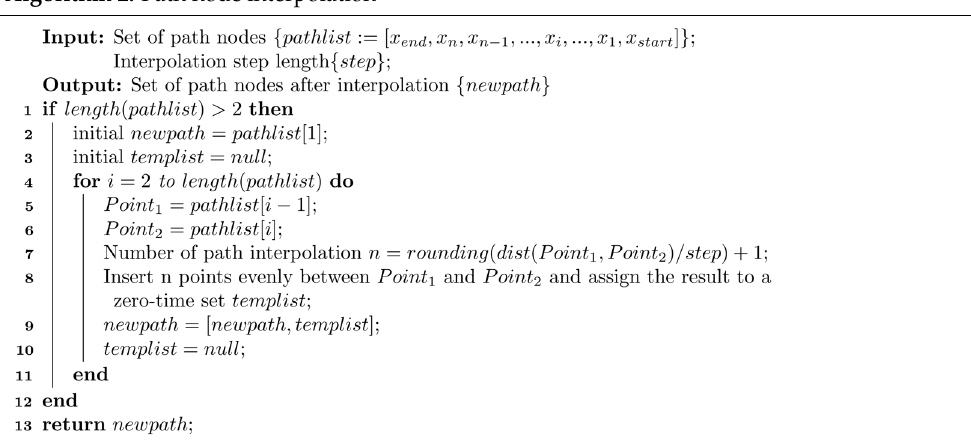
Algorithm 2: Path node interpolation